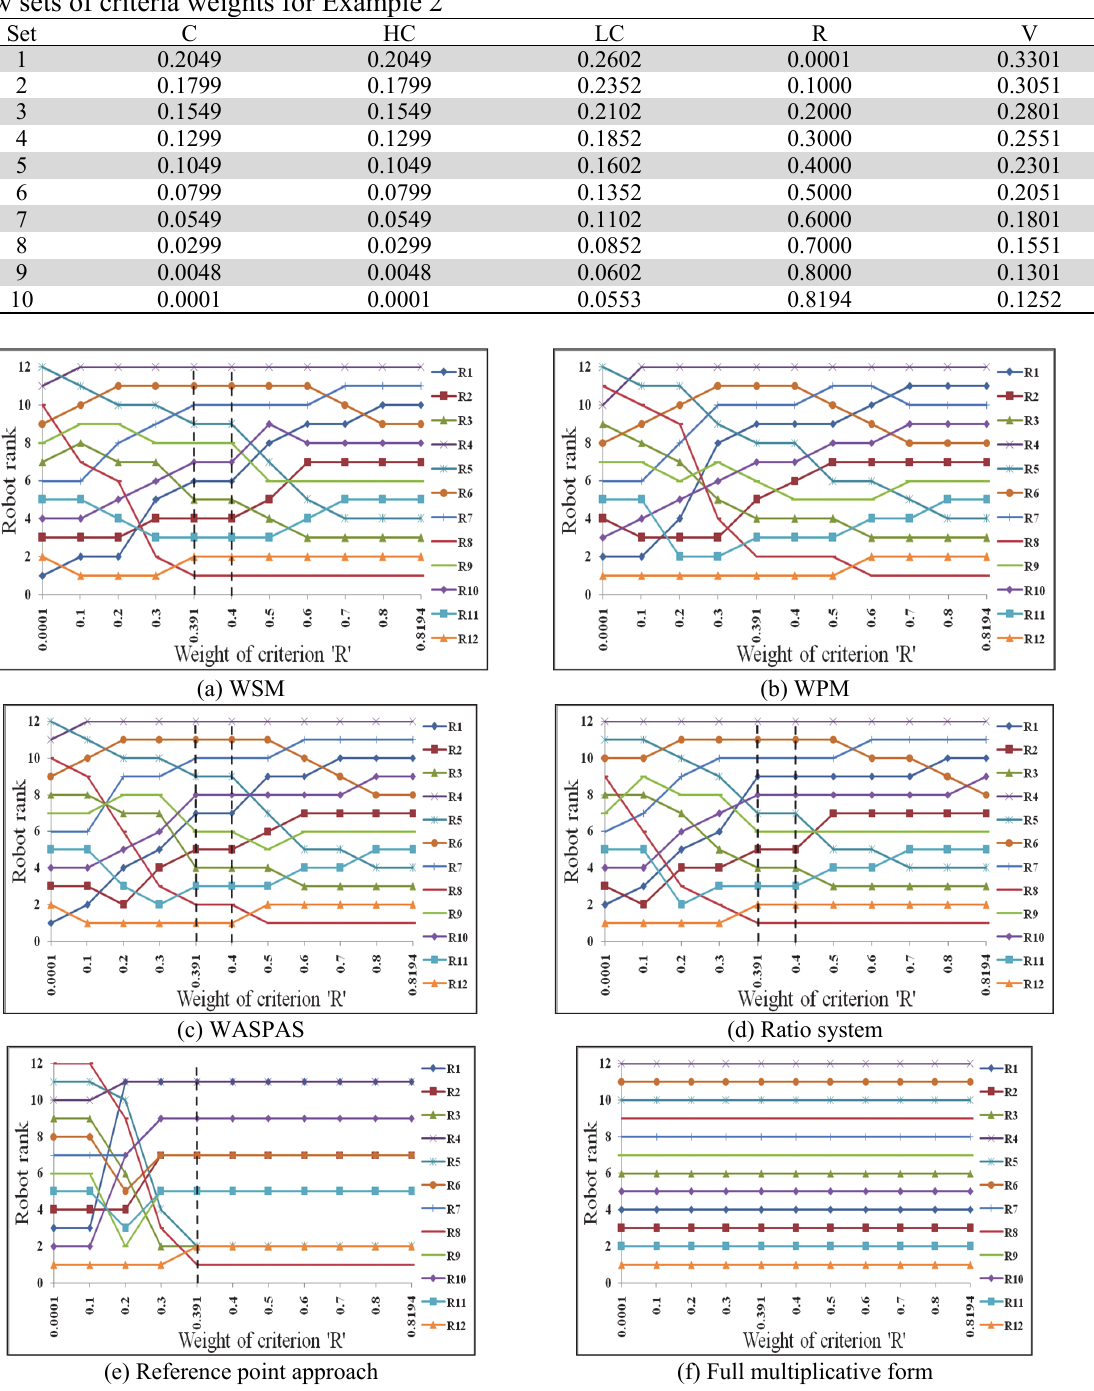
New sets of criteria weights for Example 2